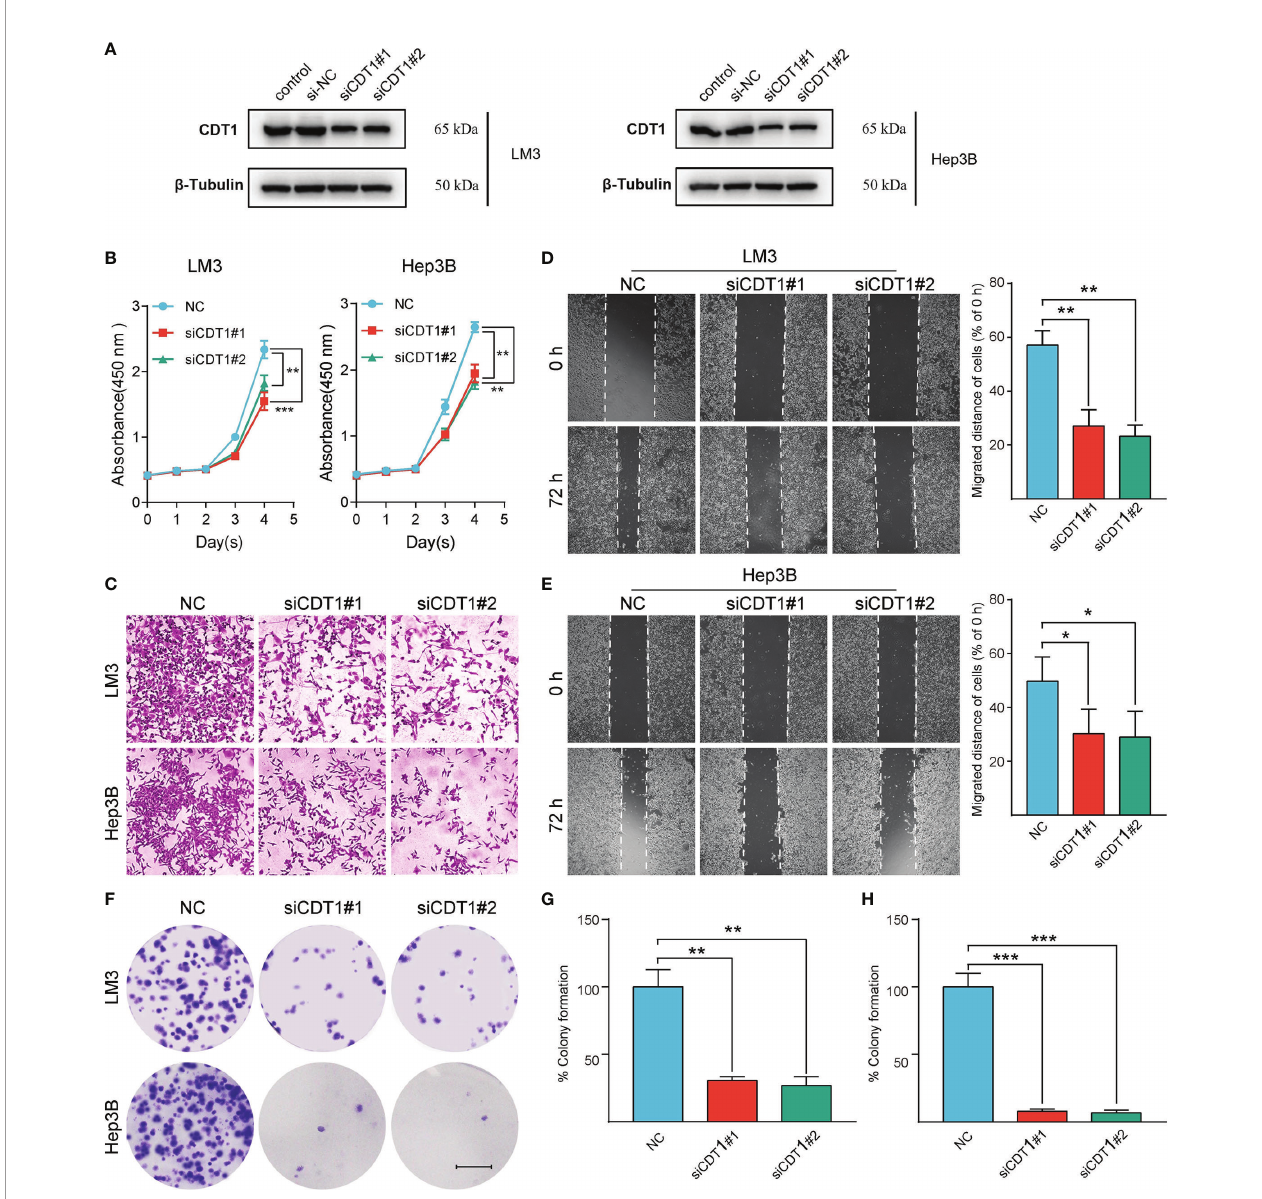
FIGURE 11 | Silencing of CDT1 inhibited the proliferation, migration and invasion of HCC cells. (A) Western blot detection of CDT1 expression after knockdown of CDT1 in liver cancer cells. (B) The effect of CDT1 knockdown on cell viability at 24, 48, 72 and 96h after seeding in plates was measured by CCK-8 assay. (C – E) Transwell analysis and wound healing assay re fl ected the migration ability of LM3 and Hep3B cell lines. (F) Images of the colony formation assay after knockdown of CDT1 in HCC cells (G, H) Relative quanti fi cation of the colony areas is shown. Scale bars in (F) equal 5mm. Data are expressed as means ± SD of three independent experiments. *p < 0.05, **p < 0.01, ***p <